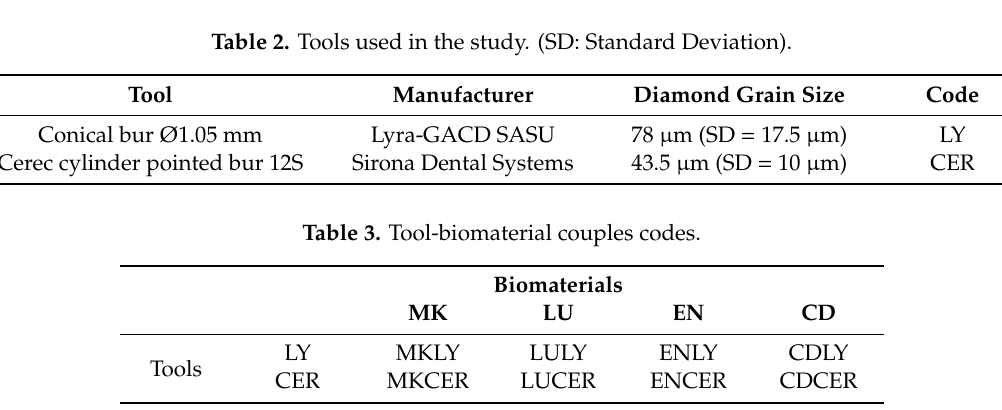
Figure 3. Diagram of experiment protocol.